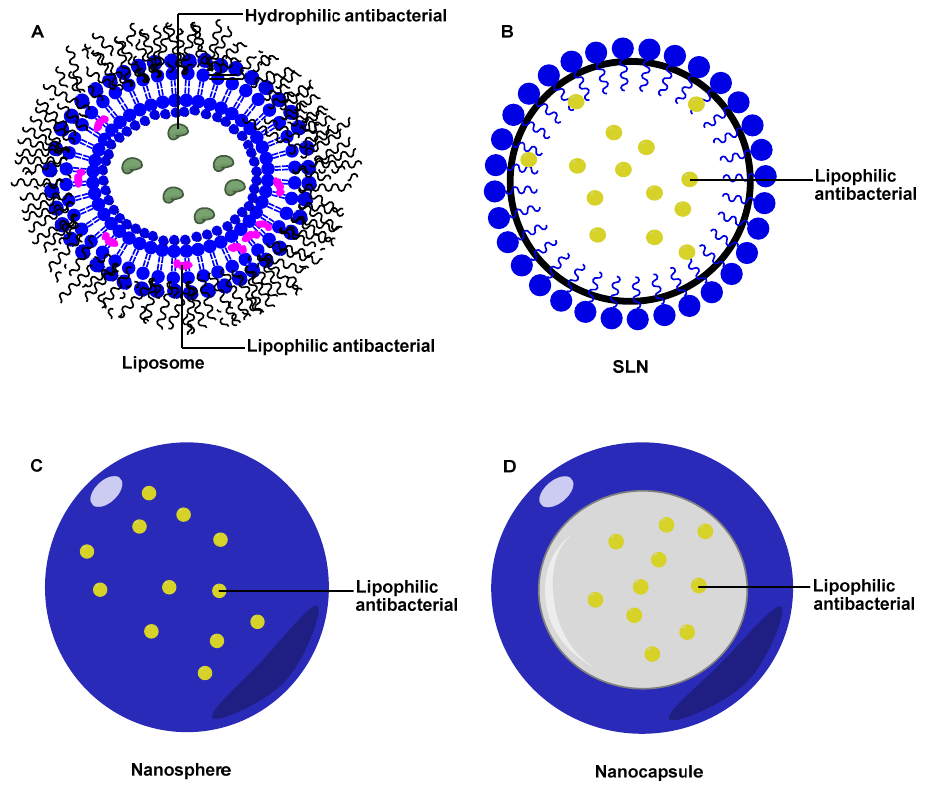
Figure 3. Commonly used antimicrobial delivery vectors: liposome ( A ), solid lipid NPs (SLN) ( B ), polymer NPs including nanosphere ( C ) and nanocapsule ( D ).